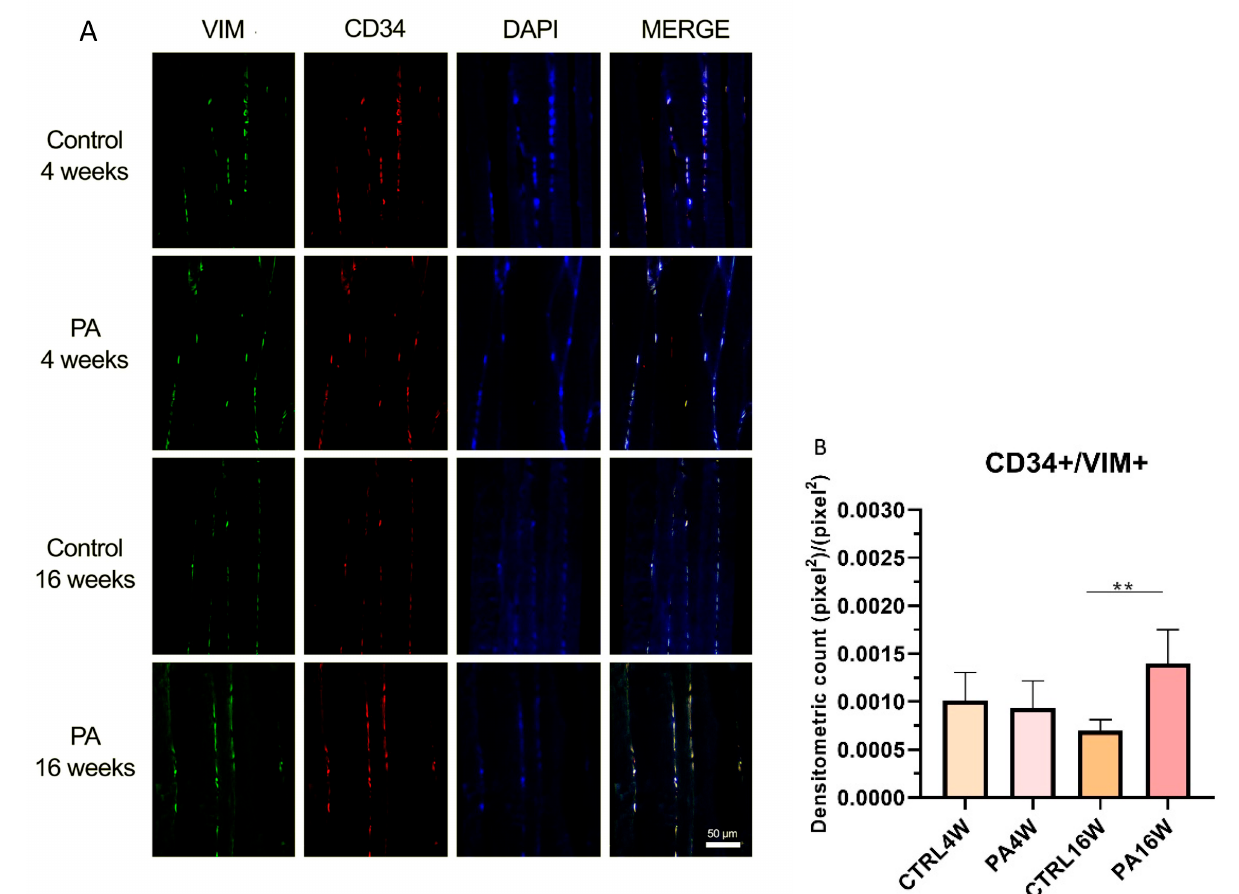
Figure 6. ( A ) Representative images of double immunofluorescence staining for muscle tissue TCs as determined by CD34+/VIM+. CD34 (red) and VIM (green) immunostaining with 4 (cid:48) ,6-diamidino-2-phenylindole (DAPI; blue) counterstain for nuclei. ( B ) Comparison between PA16W and CTRL16W highlights a highly significant higher expression of TCs in exercised rats at 16 weeks (** p < 0.01). No other comparisons show to be significant. Data were tested for normality with the Kolmogorov–Smirnov and Shapiro–Wilk test, and differences between experimental groups were evaluated by using one-way ANOVA, followed by Tukey’s multiple comparison post hoc test. The slides are scanned by confocal laser scanning microscopy (CLSM; Zeiss LSM700, Oberkochen, Germany) at 200 × magnification. Scale bars: 50 µ m. CTRL4W, control sedentary rats sacrificed at 4 weeks; PA4W, rats performing physical exercise sacrificed at 4 weeks; CTRL16W, control sedentary rats sacrificed at 16 weeks; PA16W, rats performing physical exercise sacrificed at 4